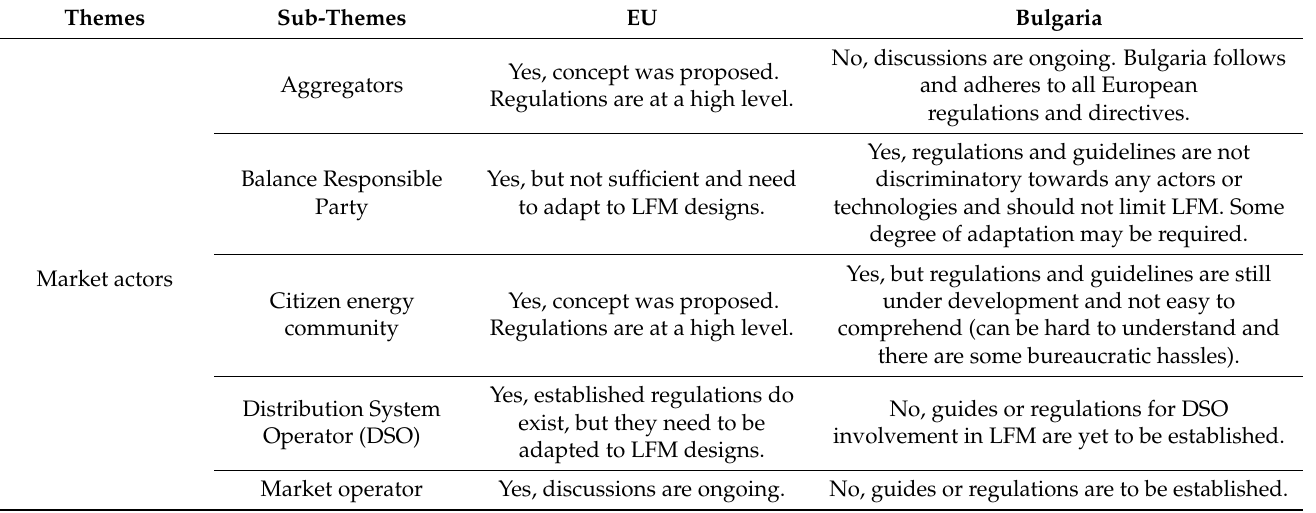
Table 2. The regulation overview at EU level and Bulgarian local flexibility